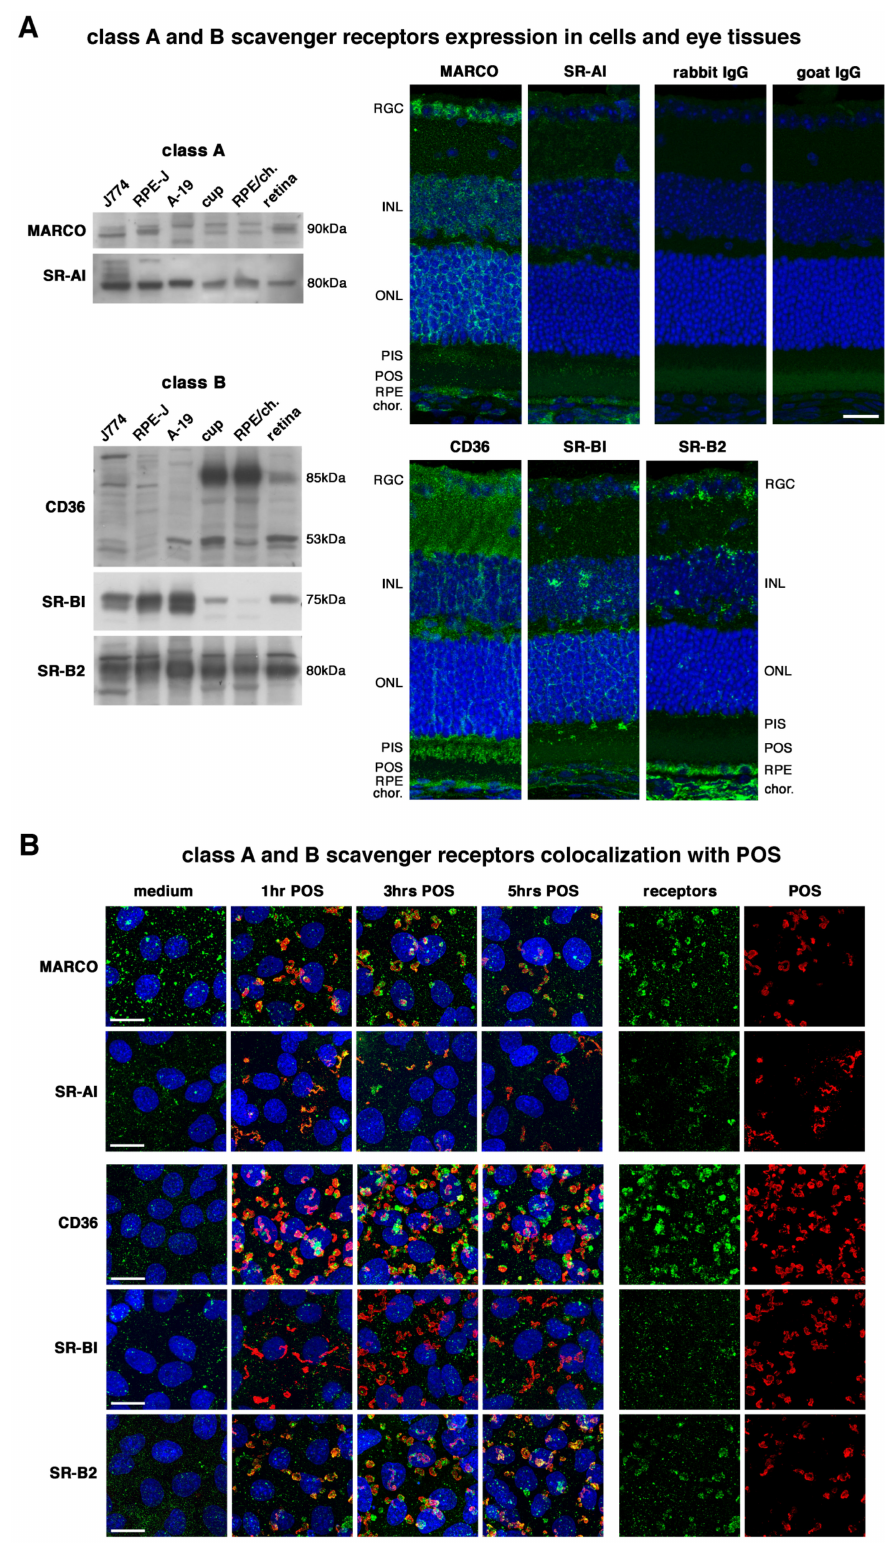
Figure 1. All receptors are expressed by RPE cells and all except SR-BI colocalize with POS. Representative immunoblots ( A ) show that class A scavenger receptors MARCO and SR-AI (left) and class B CD36,